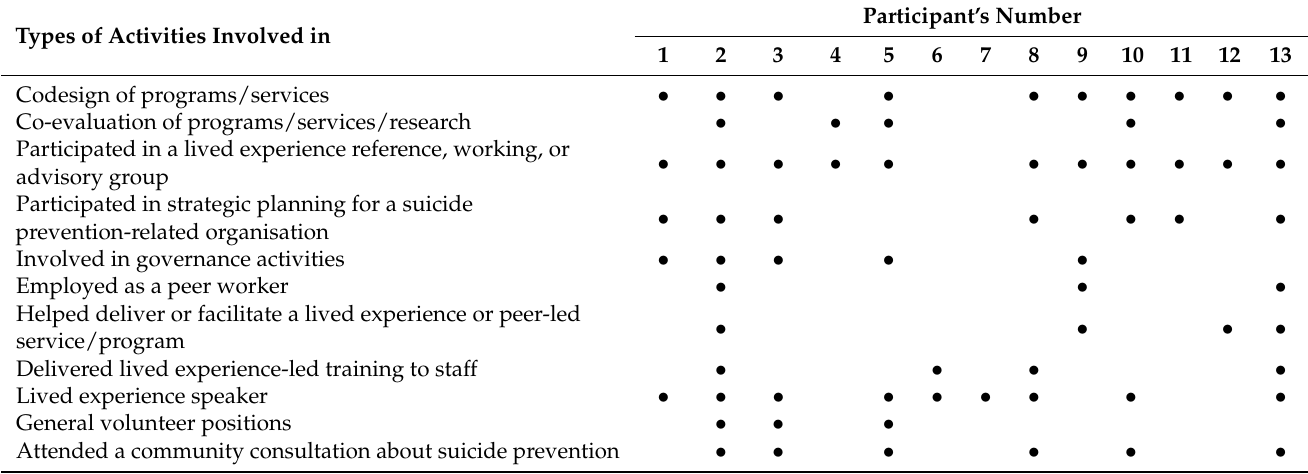
Table 1. Participants involvement in different types of LEW